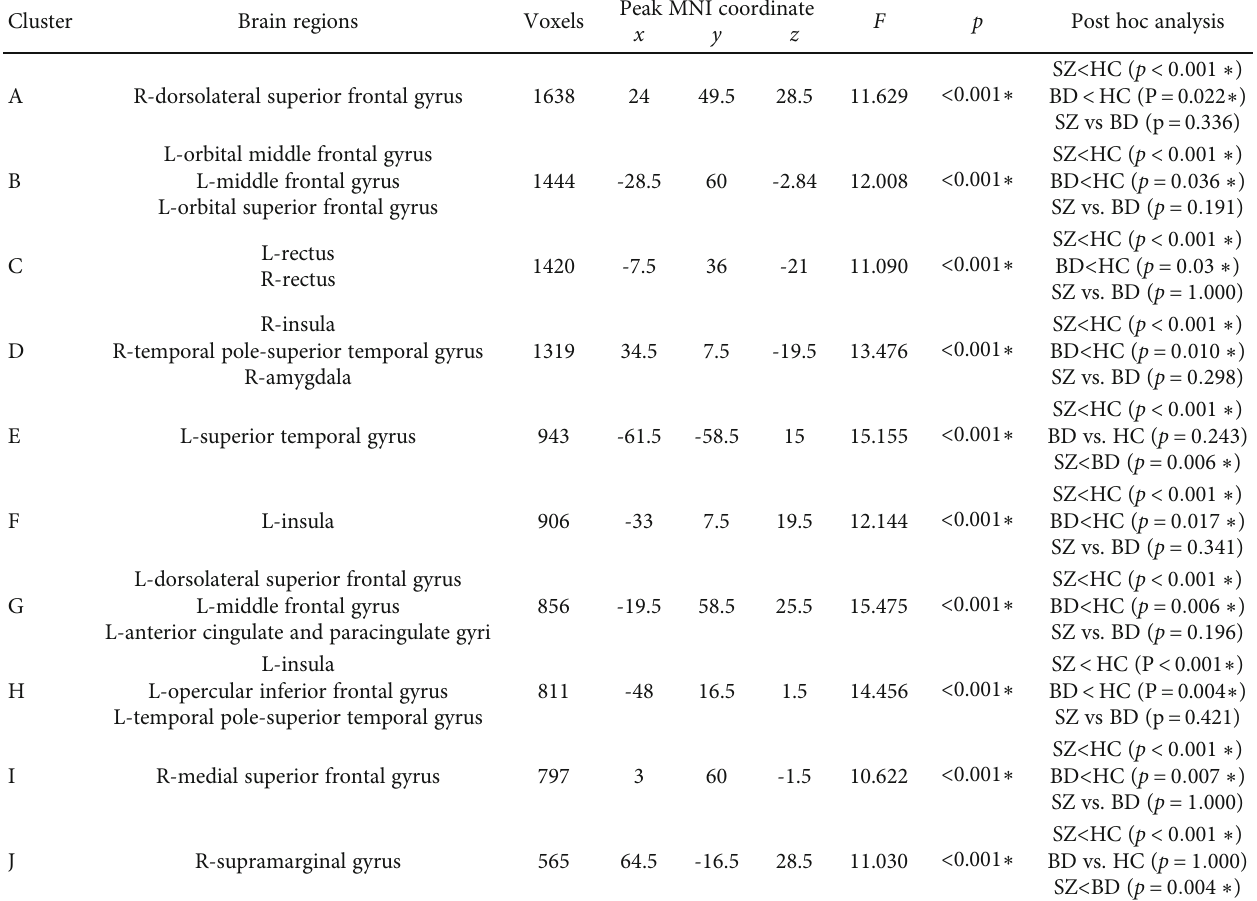
Table 2: Clusters showing signi fi cant di ff erences across BD, SZ, and HC groups with one-way ANCOVA.